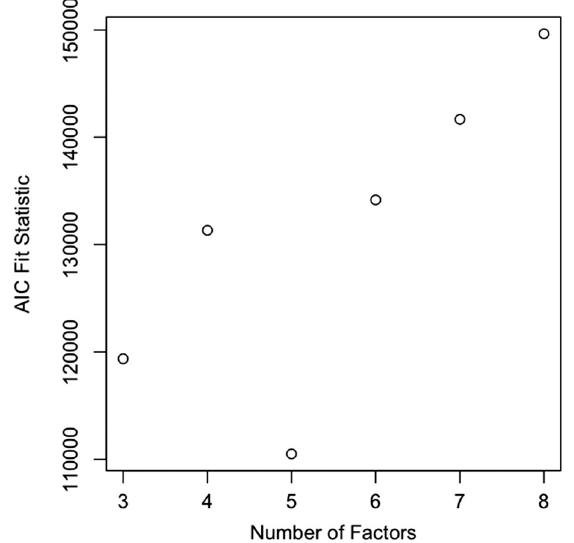
FIG. 2. The AIC values for the factor models that resulted from the criteria laid out in Sec. III A for the BEMA used in CFA with the full BEMA dataset. As can be seen, the 5 factor model is the preferred factor